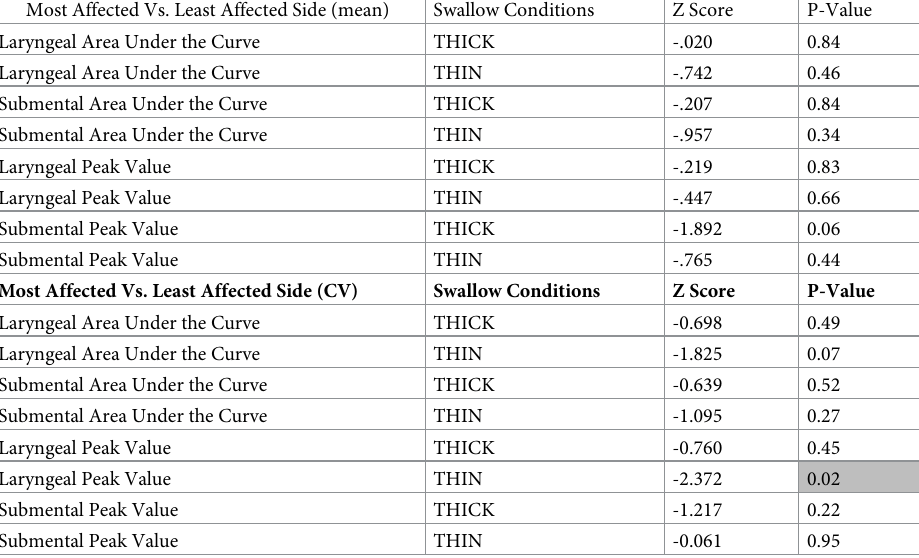
Table 2. Statistical results for differences between the more and less affected side.